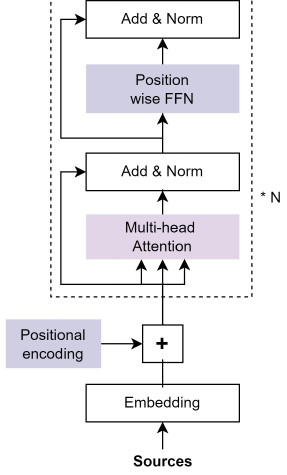
Figure 8. Encoder